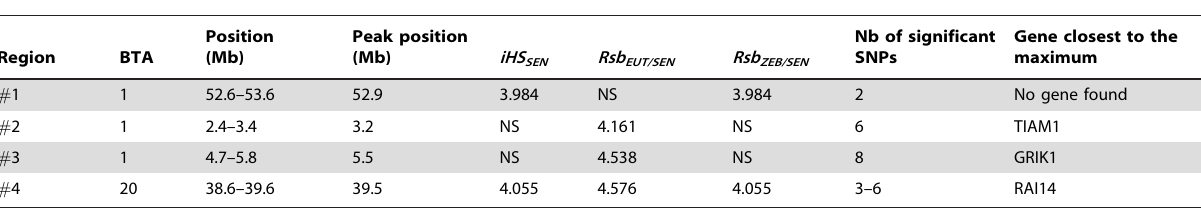
Table 2. Chromosomal regions under